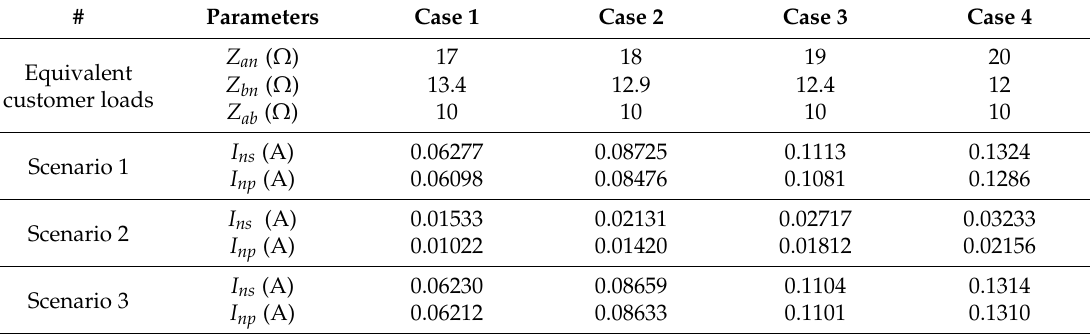
Table 2. Simulation data for the estimation of parameter g in three different